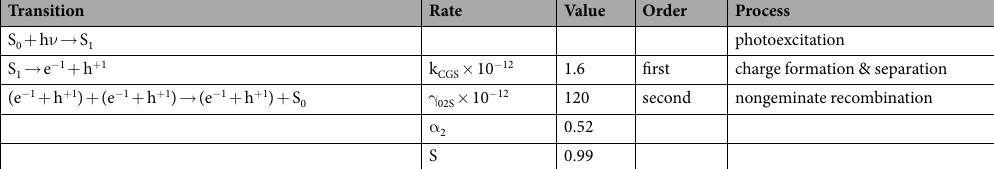
Table 3. Special model for PBDTfDTBO blend, and its reaction order. S 1 are excitons generated by light absorption, (e − 1 + h + 1 ) are a loosely bound charge pair. Since the extinction coefficient of the species is not known, standard units for the second order rate constants could not be obtained. Instead [absorbance units/ second] was